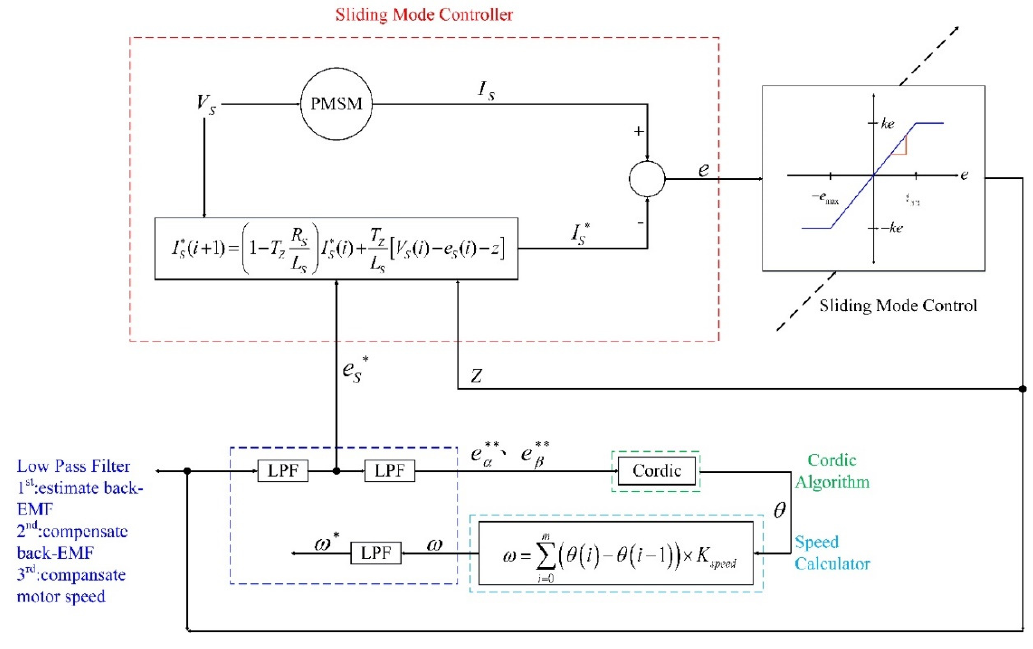
Figure 2. Rotor position estimation and control.